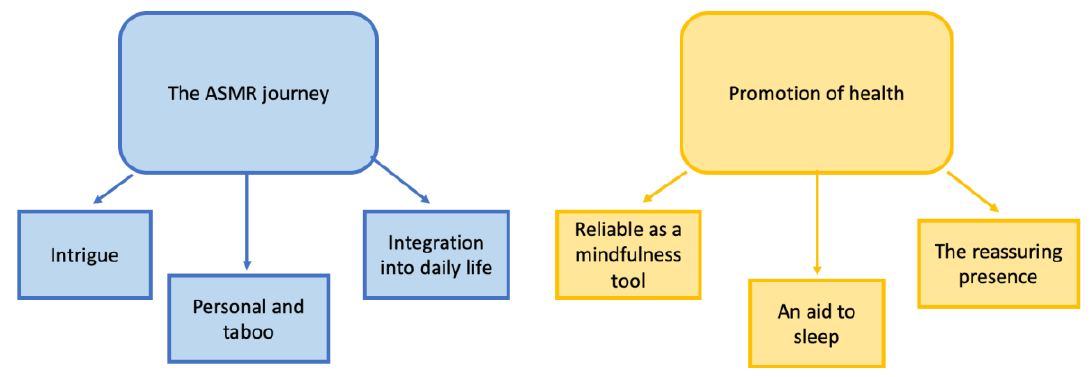
Figure 1. Thematic map outlining themes and sub-themes.